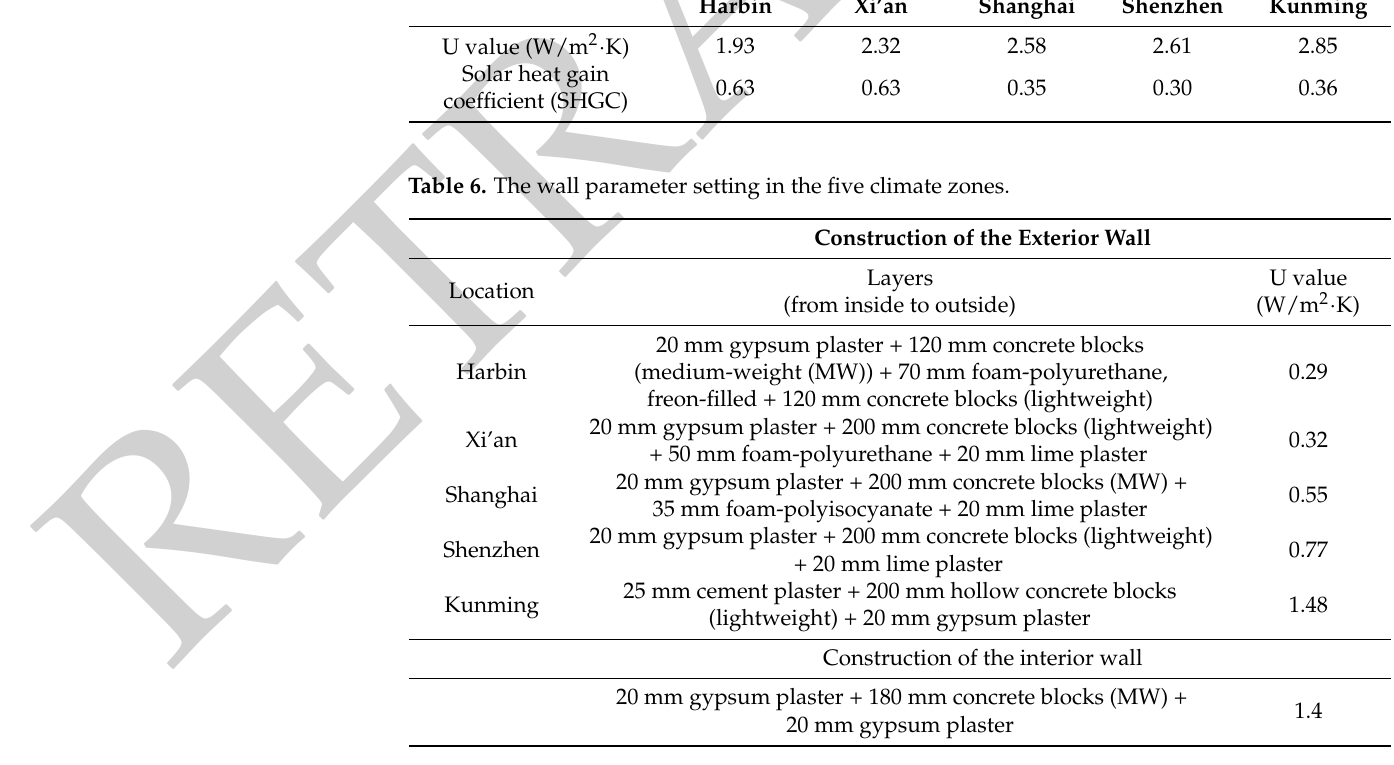
Table 6. The wall parameter setting in the five climate zones.